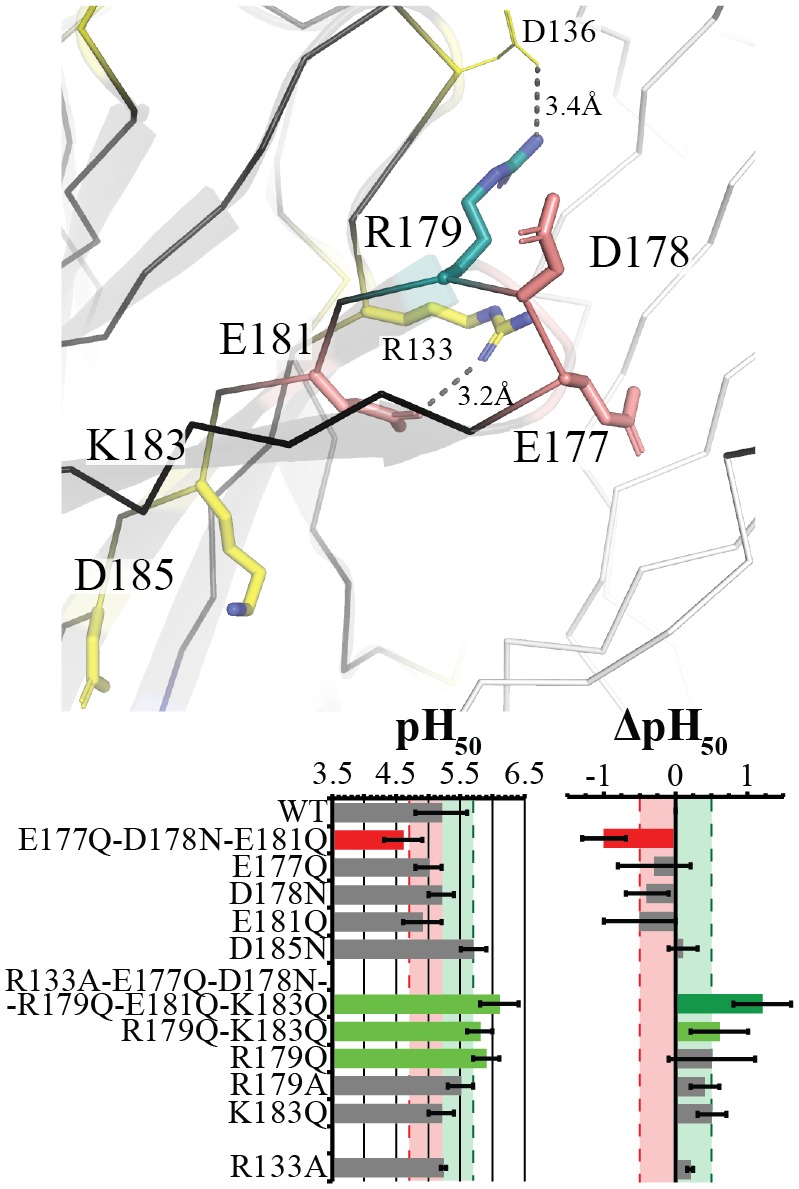
Loop C residues modulate activation through a complex network of interactions.Stick representation of the evaluated Arg, Asp, Glu, and Lys residues are labeled and color coded based upon effect, with Asp/Glu pink residues producing a strong decrease in pH50 when mutated in combination, and yellow residues producing a nonsignificant or weak effect. R179 is shown in teal. The main subunit is shown in black with ribbon and cartoon representation, whereas the complementary neighboring subunit is represented in white ribbon, with important motifs/β-sheets labeled. Distances of intrasubunit contacts are shown between D136 and R179, as well as R133 and E181. Table of the pH50 and ΔpH50 are shown below with mean values ± standard deviation for evaluated mutants with recorded values noted in S1 Table. Light red and green zones with dashed lines represent the respective ½ log decreases and increases from Wt. Values outside this region are color coded for ease of interpretation with red as decreases and green and dark green as varying degrees of increases. Wt, wild-type.